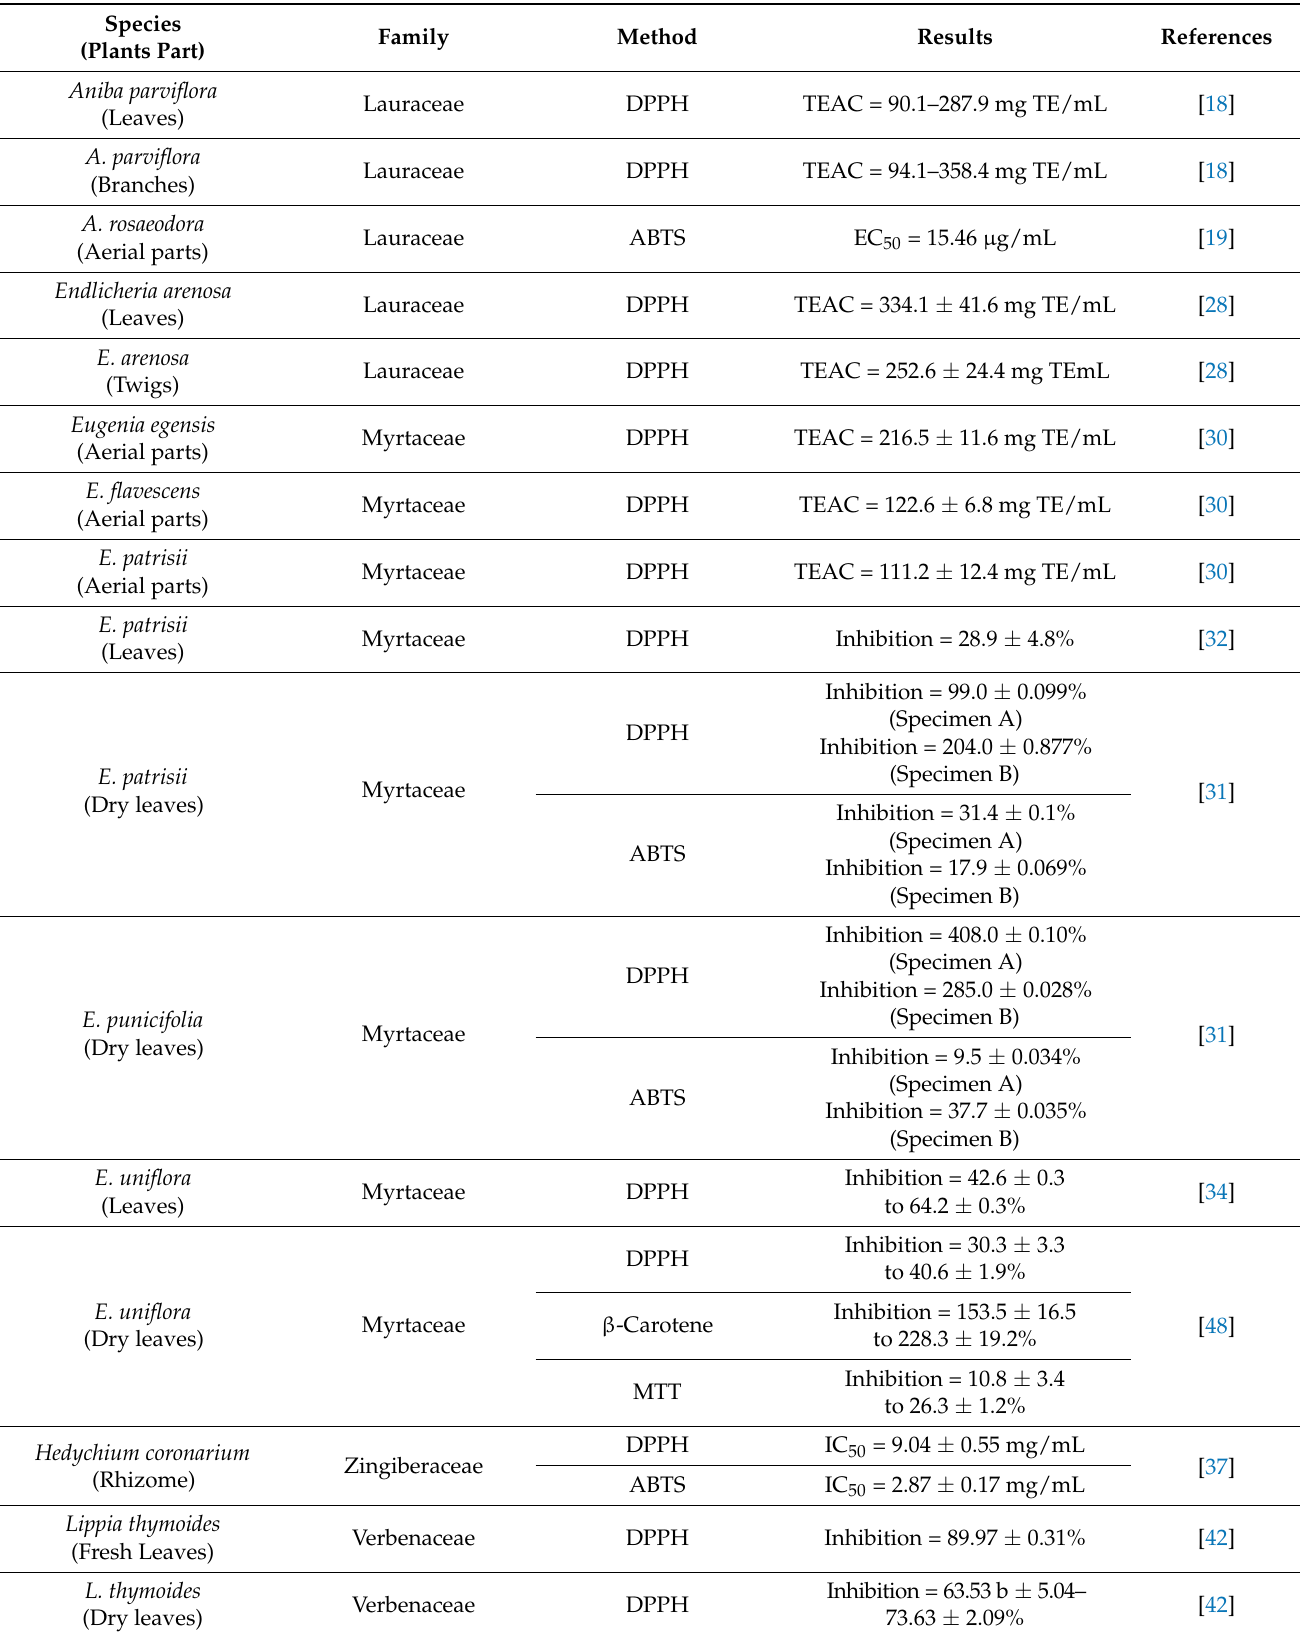
Table 2. Essential oils of the Amazon and their antioxidant